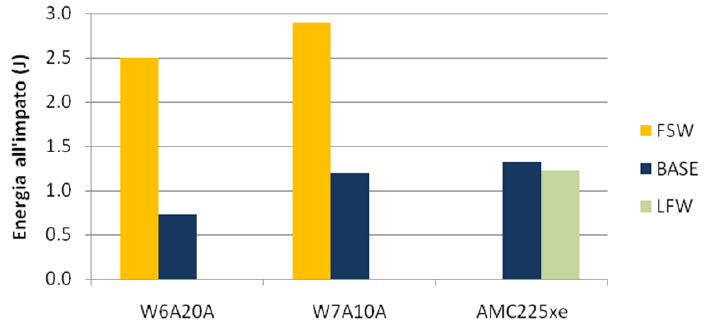
Figura 13: Risultati delle prove di resilienza relativi al materiale base e ai giunti FSW per